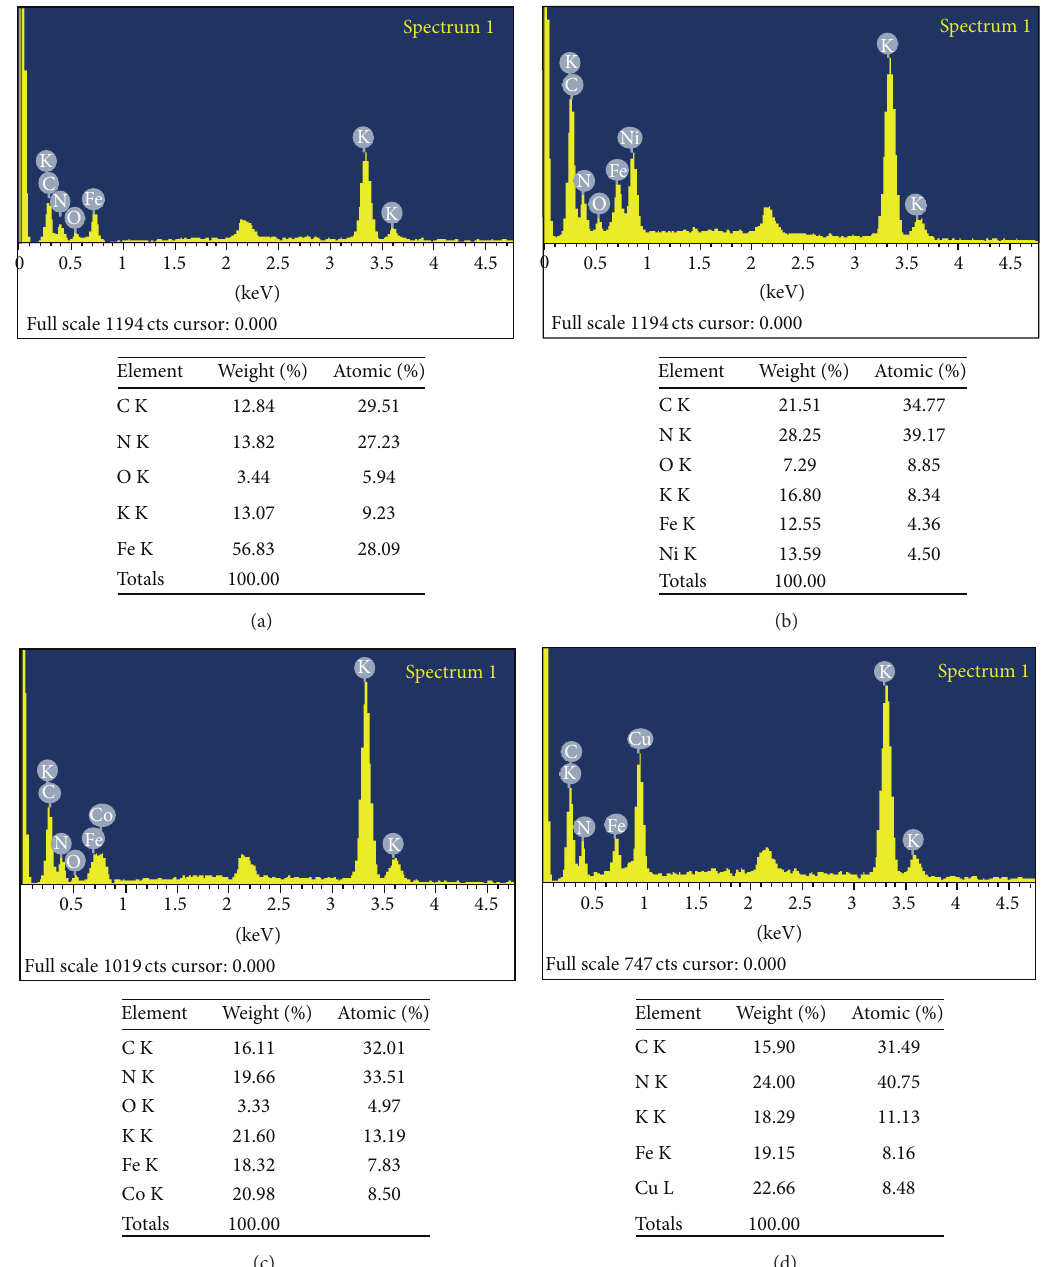
Figure 4: EDX pattern of (a) Fe, (b) Ni, (c) Co, and (d) Cu HCF nanoparticles using Aegle marmelos.